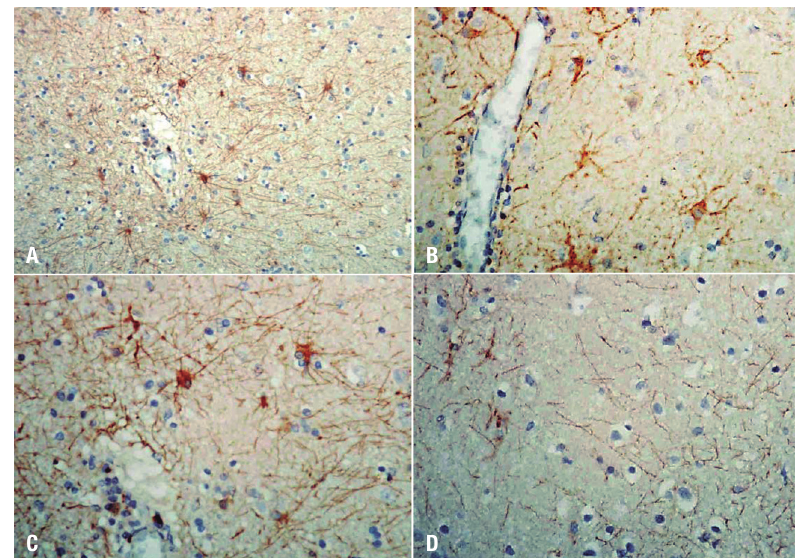
specific antibody for measles.